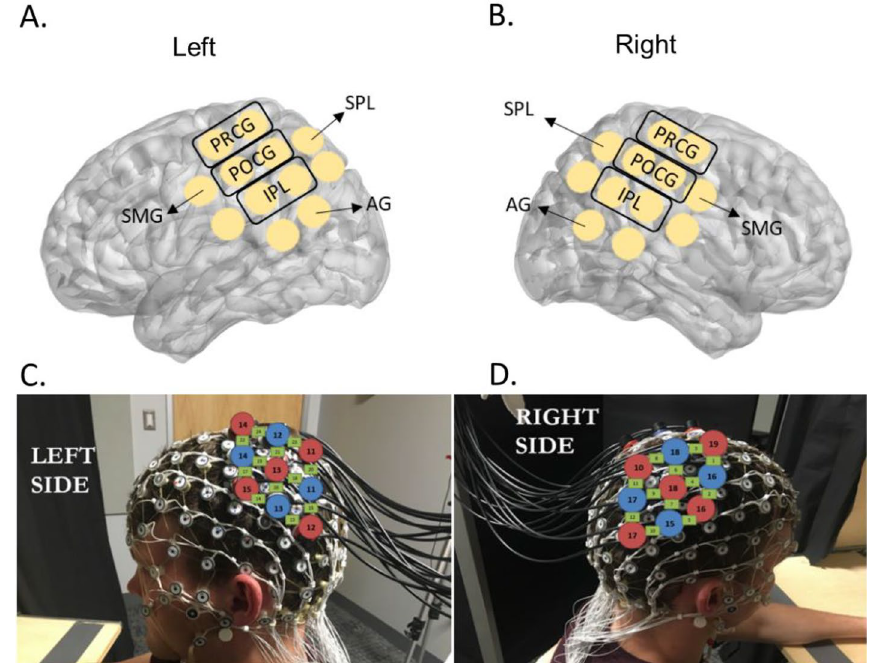
Figure 2. fNIRS probe placements and the ROI assignments. Written permission for publication of participant pictures has been